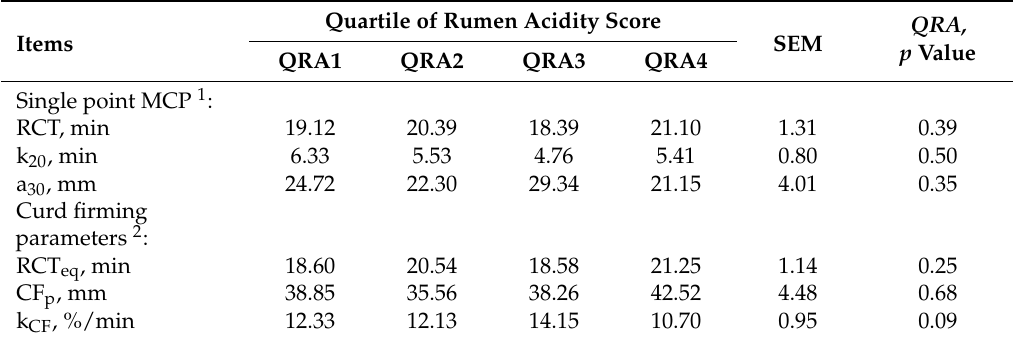
Table 5. Effect of the quartile of rumen acidity score (QRA1, greatest rumen acidity, to QRA4, lowest rumen acidity) on single point milk coagulation properties (MCPs) and the curd firming equation parameters of Holstein